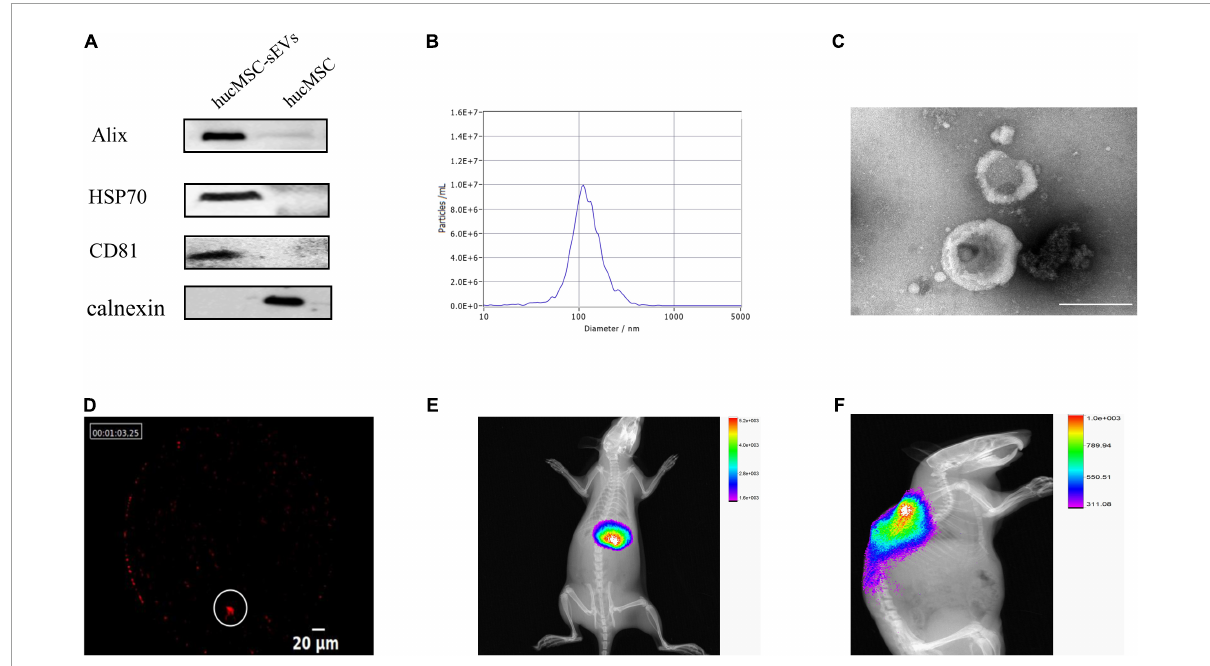
FIGURE1 Characterization and tracing of hucMSC-sEVs. (A) Western blot analysis of surface markers for hucMSC-sEVs. (B) Particle size distribution and concentration measured by NTA. (C) Representative image of hucMSC-sEVs by TEM. Scale bars, 200 nm. (D) Distribution of Dir-labeled hucMSC-sEVs at the original site of injury 24 h after intravascular transplantation. Scale bars, 20 µ m. (E) Distribution of Dir-labeled hucMSC-sEVs 24 h after intravascular transplantation in vivo . (F) Distribution of Dir-labeled hucMSC-sEVs 7 days after intralesional injection in vivo